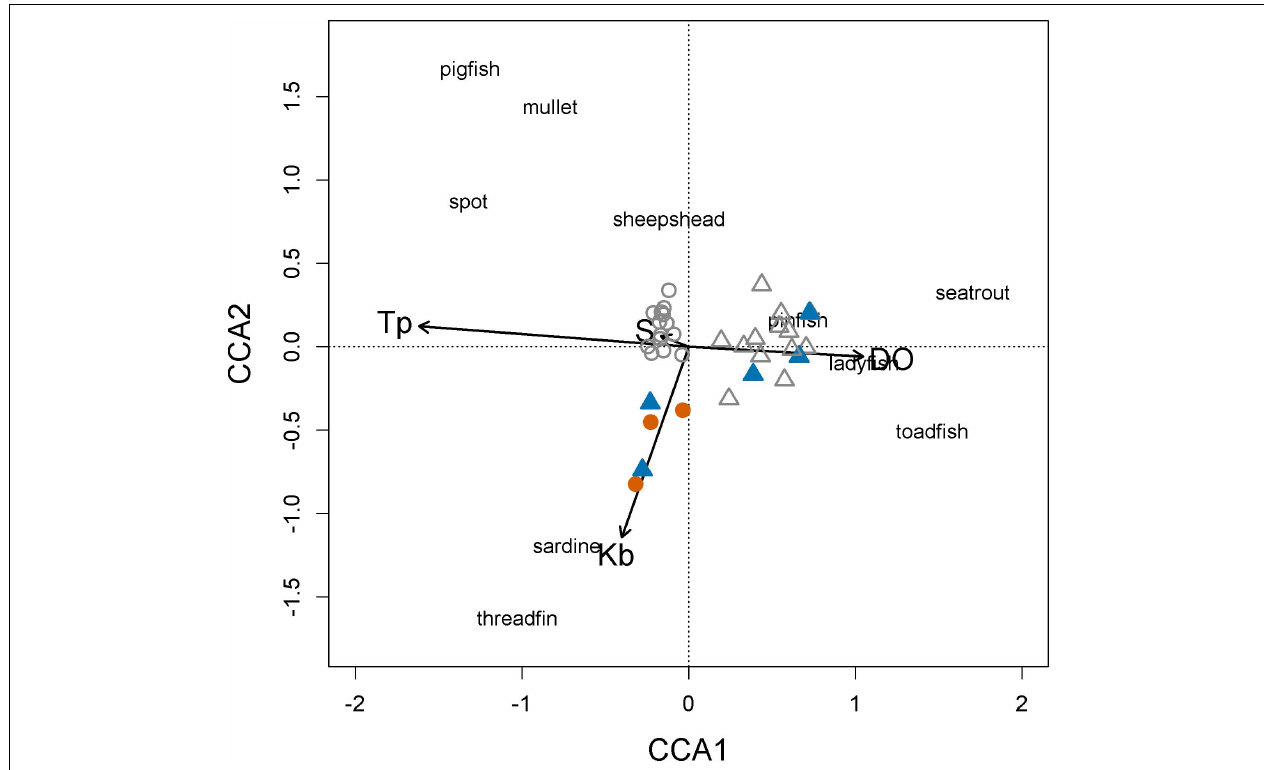
FIGURE 10 | Canonical correspondence analysis (CCA) of the prey assemblage from purse seine catches, from July 2005 through March 2019. Symbols: • = summer red tide conditions, = summer non-red tide conditions, (cid:78) = winter red tide conditions, (cid:49) = winter non-red tide conditions, environmental vector codes: DO: dissolved oxygen (mg l − 1 ); Tp: temperature ( ◦ C); S: salinity (ppt); Kb: Karenia brevis cell density (cells l − 1 (cid:35)